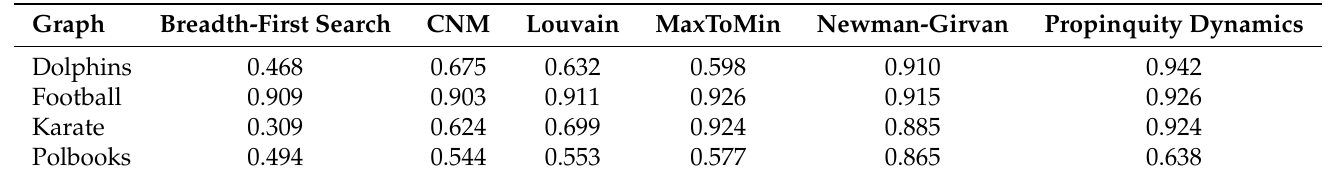
Table 3. Normalized Mutual Information.